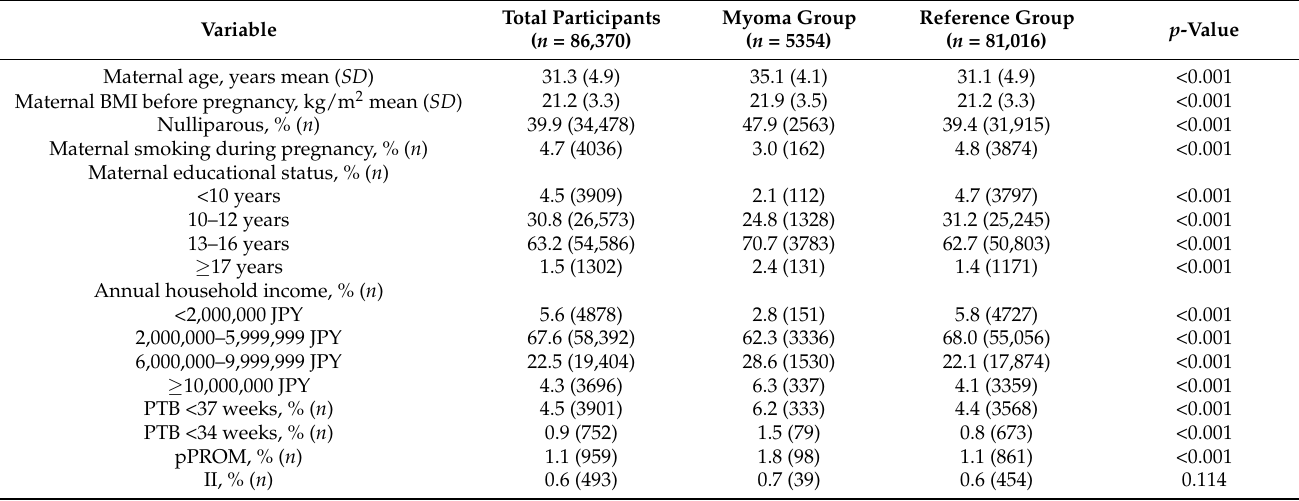
Table 1. Demographic and clinical characteristics and obstetric outcomes of participants stratified according to the uterine myoma status.